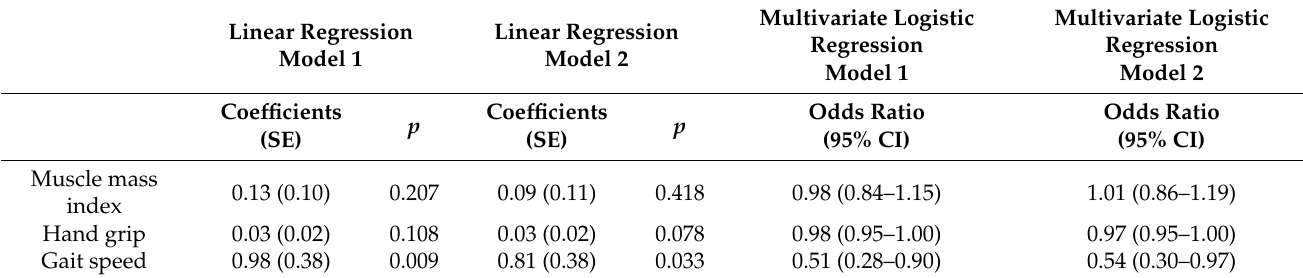
Table 3. Longitudinal associations of sarcopenia parameters with cognitive decline measured by the